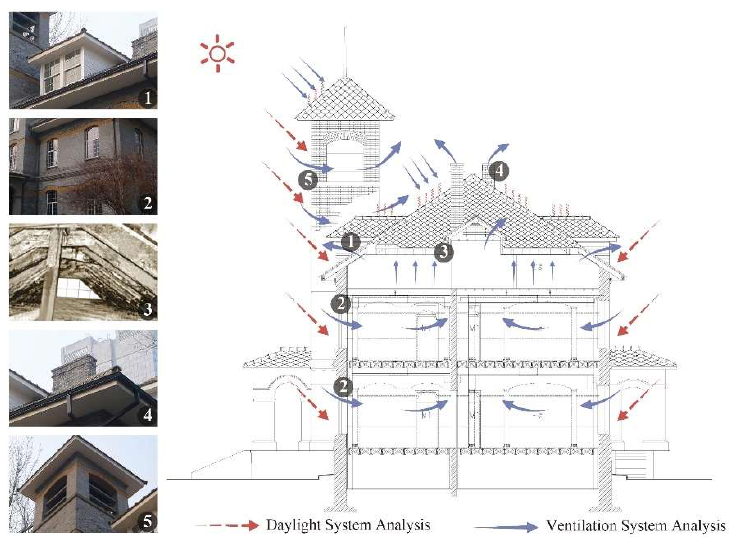
Figure 14. Ventilation system (source: author).